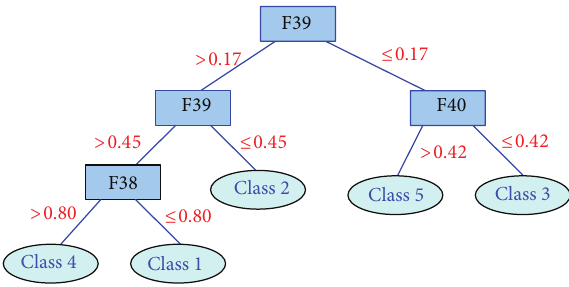
Figure 18: Decision tree trained on the features selected with kernelized mutual